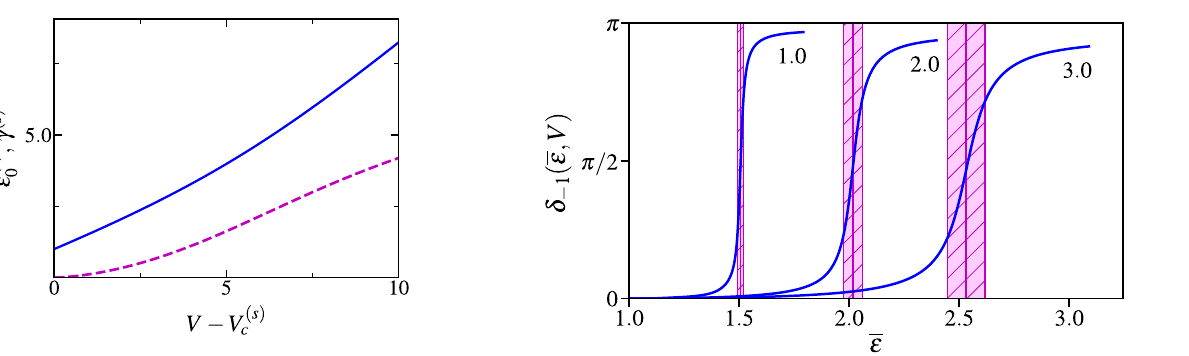
Fig. 3 Dependence of the position (cid:10) ε ( s ) (solid line) and the width (cid:10) γ ( s ) 0 (dashed line) of the energy level of the positron quasistationary state on (cid:16) (cid:15) V − V ( s ) c for (cid:2) = − 1 and R = 1 / 5 supercriticality